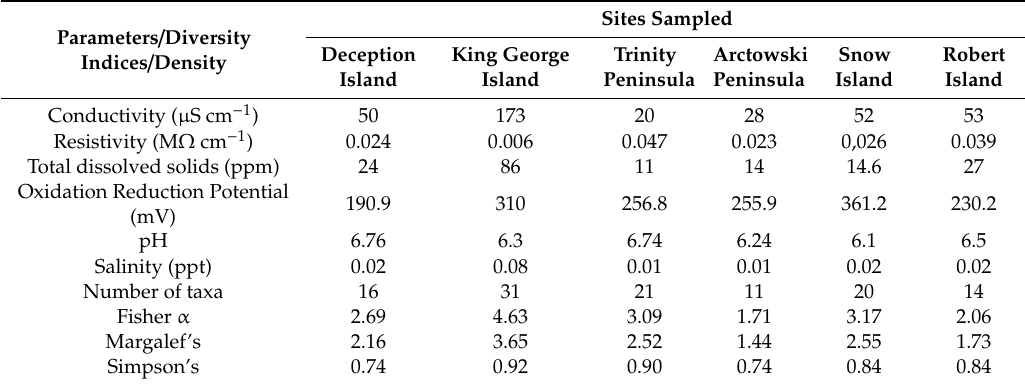
Table 2. Physicochemical parameters of melted snow sampled in di ff erent sites of Antarctic Peninsula and diversity indices fungal.